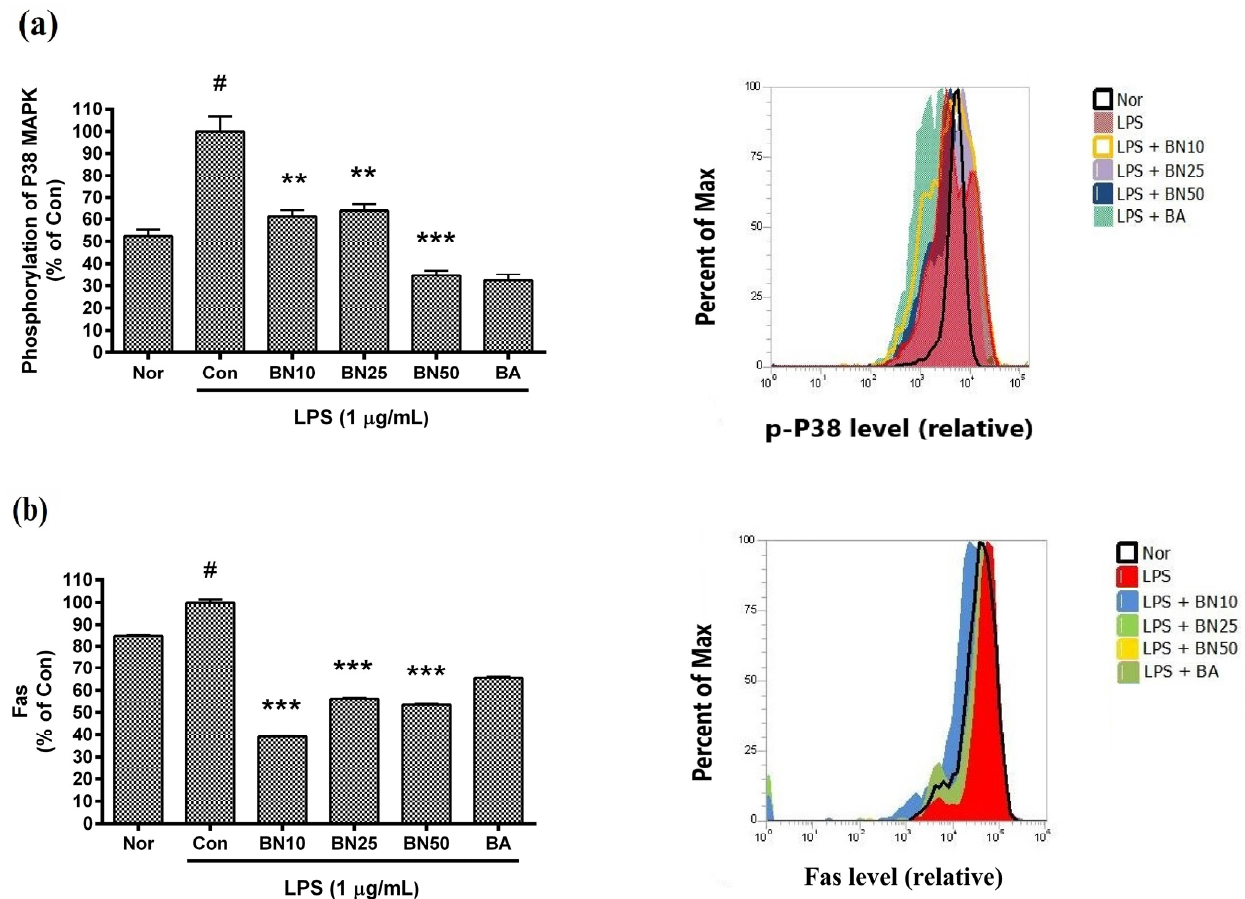
Figure 6. Effect of baicalin on levels of phosphorylated P38 MAPK ( a ) and Fas ( b ) in LPS-stimulated RAW 264.7 macrophages. Levels of phosphorylated P38 MAPK and Fas were measured via flow cytometric analysis. Values are presented as mean ± SD of three independent experiments. Nor, normal group (media only); Con, control group (1 µ g/mL of LPS alone). BN10, BN25, and BN50 are 10, 25, and 50 µ M of baicalin, respectively; BA, baicalein (25 µ M). # p < 0.05 vs. Nor; *** p < 0.001 vs. Con; ** p < 0.01 vs. Con.